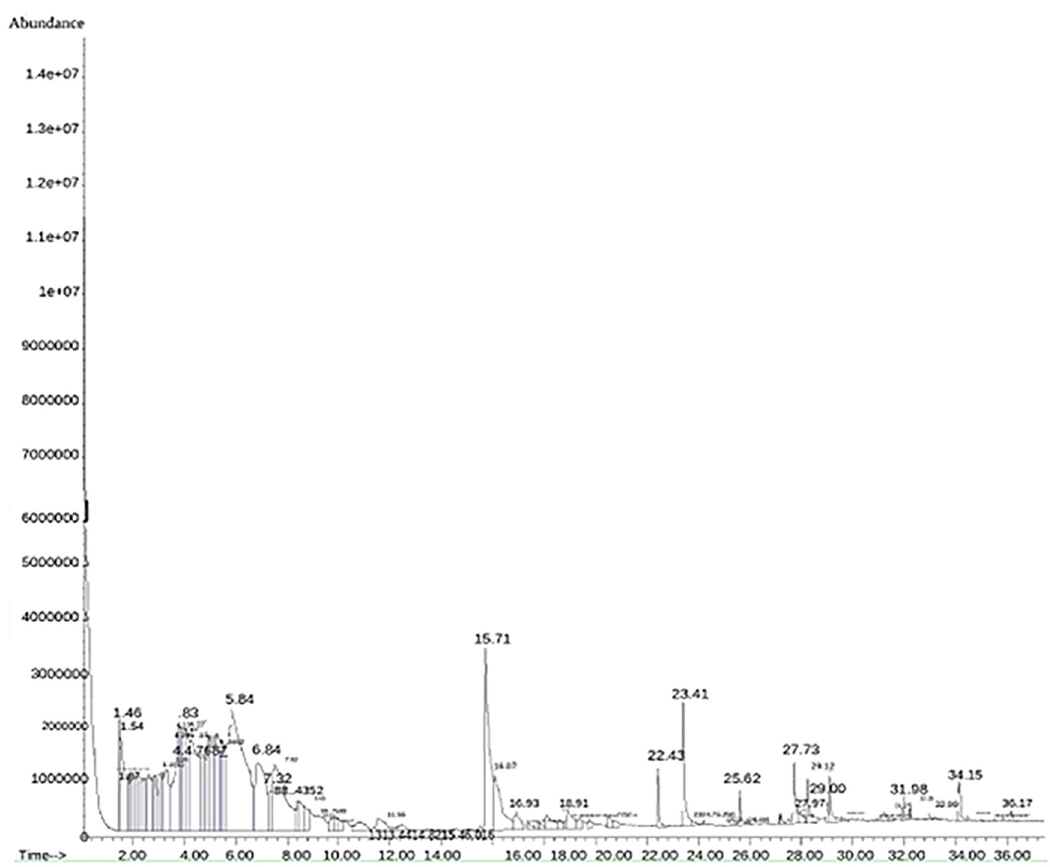
Figure 2: GC - MS chromatogram of the prepared red pepper